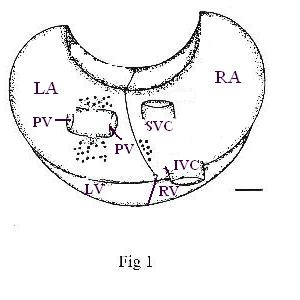
Diagram of epicardial surface of right and left atria of mouse heart viewed from their cranial aspect showing the 3 major regions in which NADPH-diaphorase positive neurons were located. The neurons are represented by dots. La= left atrium; Ra = right atrium; Pv = pulmonary veins; Svc = superior vena cava; Ivc = inferior vena cava; Lv = left ventricle; Rv = right ventricle. Calibration bar: 0.1 mm.